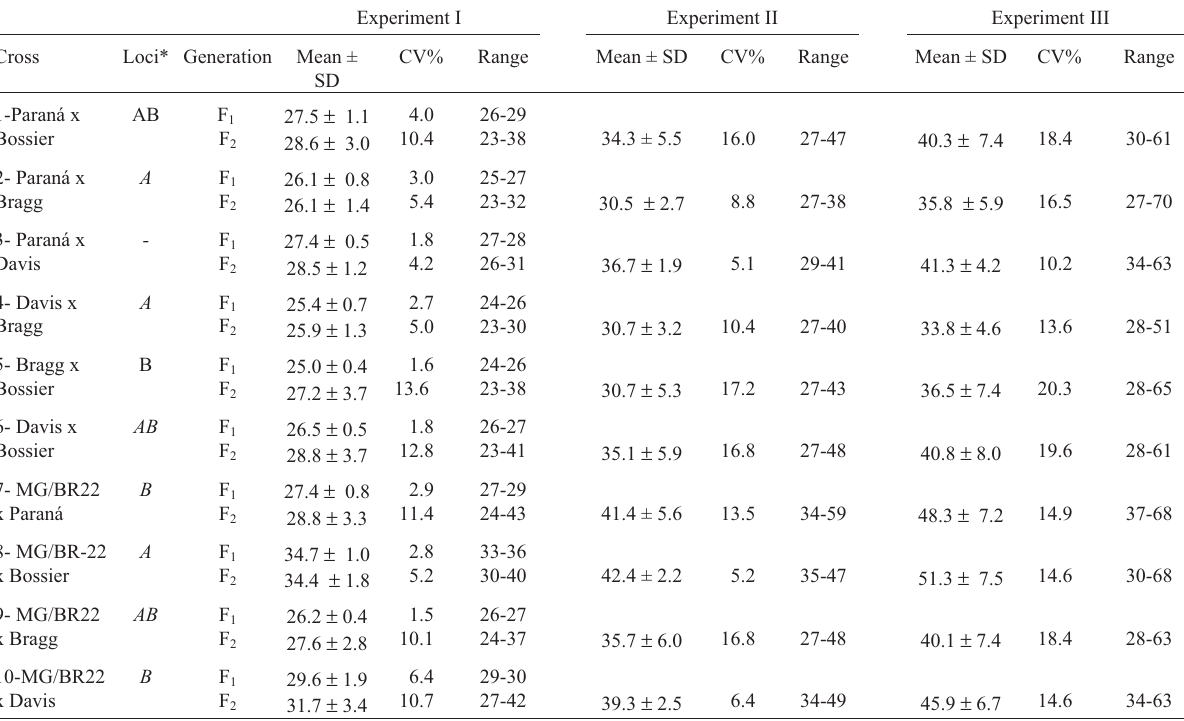
Table II - Means, standard deviation (SD), and range of number of days to flowering of F 1 and F 2 soybean populations in three experiments under short-day